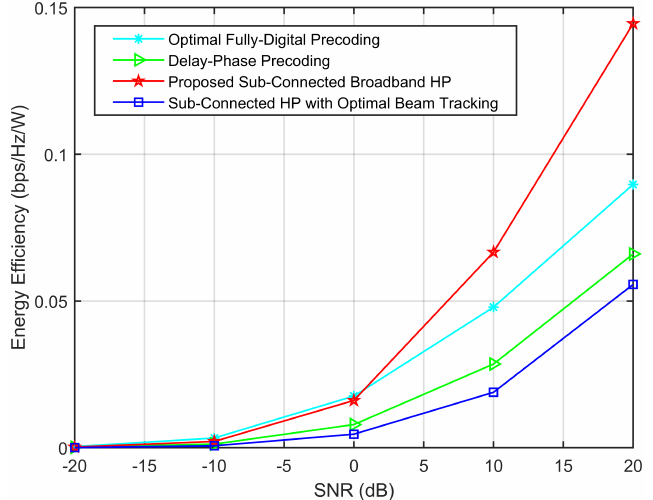
Figure 6. Comparison of energy efficiency of different precoding under high bandwidth-frequency ratio ( B = 30